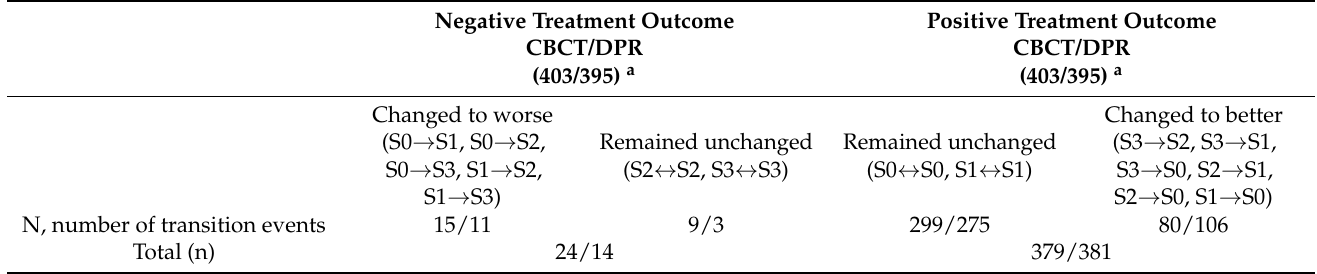
Table 3. Treatment outcome evaluation concerning two-year transitions of the periapical radiolucen- cies detected by CBCT and by